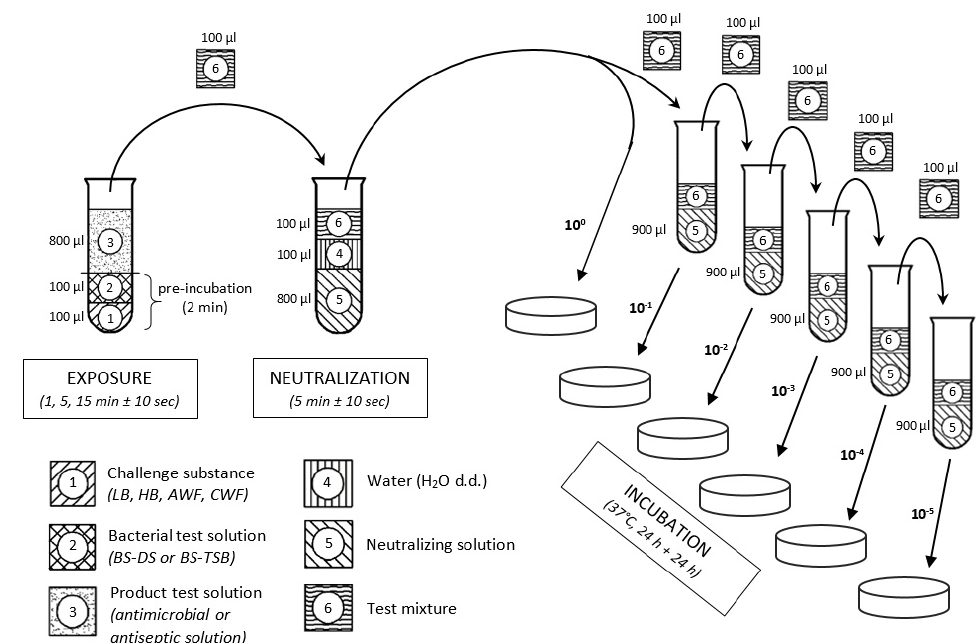
Figure 1. Schematic illustration of the quantitative suspension method based on DIN-EN-13727. Initially, challenge substance (1) and bacterial test solution (2) are pre-incubated together at RT for 2 min. Subsequently, antimicrobial or antiseptic test solution (3) is added for the desired exposure time. Thereafter, a sample of the test mixture (6) is transferred into a neutralizing solution (5) to terminate the antimicrobial effect. Finally, a 10-fold serial dilution series is prepared and samples of each step were plated on agar plates and incubated for at least 24 h [8]. (LB: Low burden; HB: High burden; AWF: Acute wound exudate; CWF: Chronic wound exudate; BS-DS: Bacterial suspension in diluent solution; BS-TSB: Bacterial suspension in TSB).